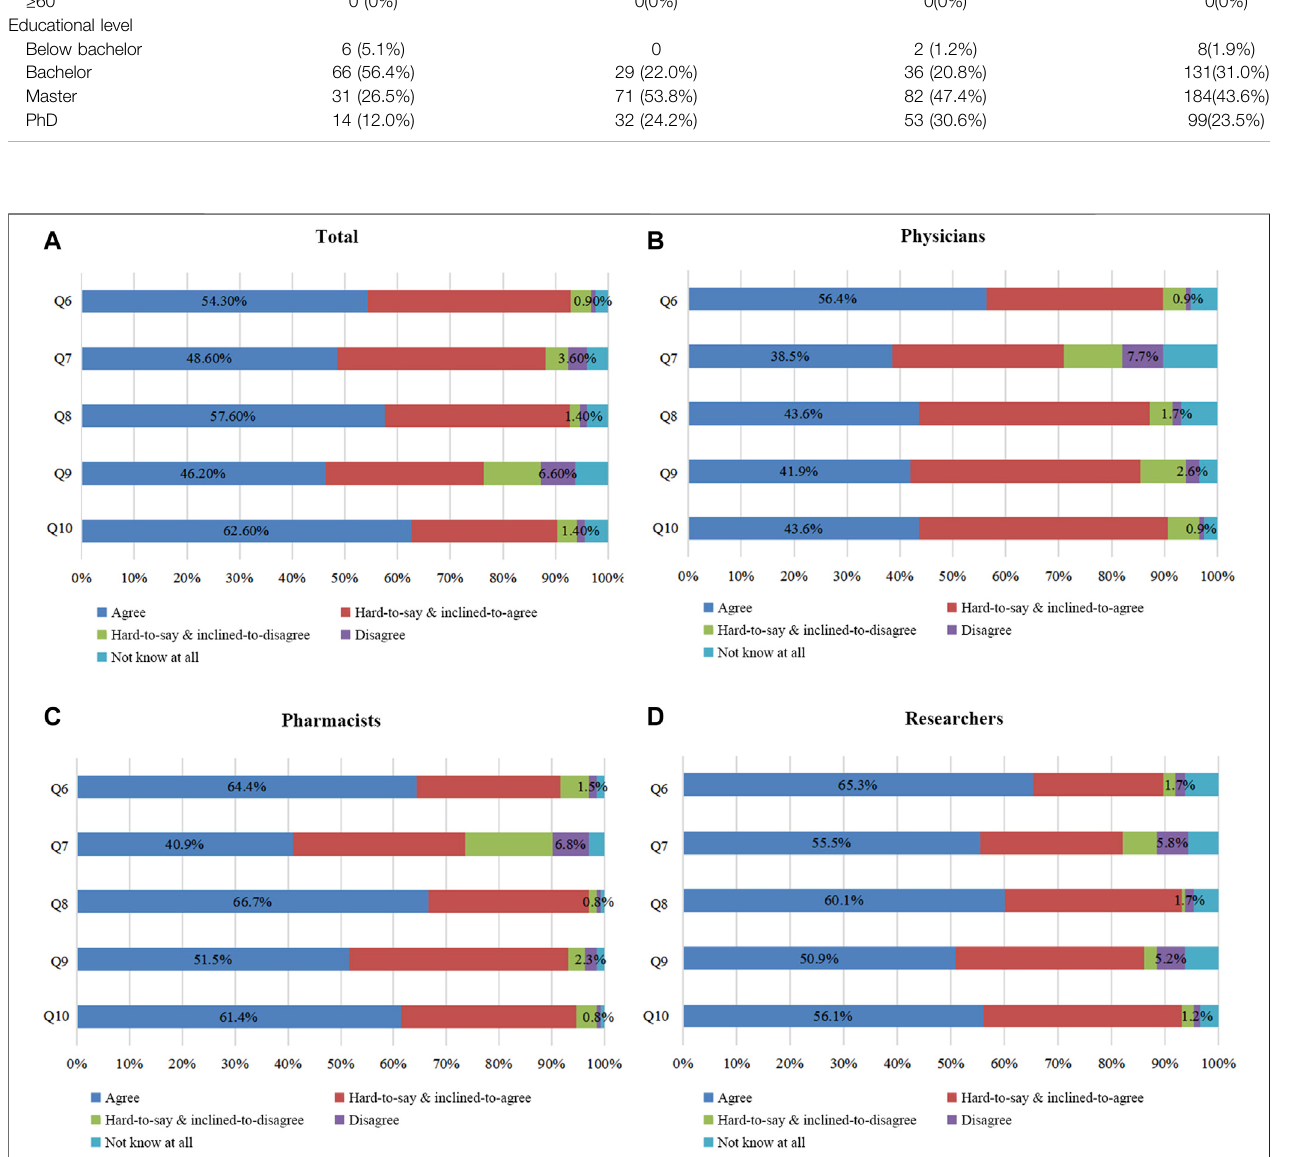
Frontiers in Pharmacology |